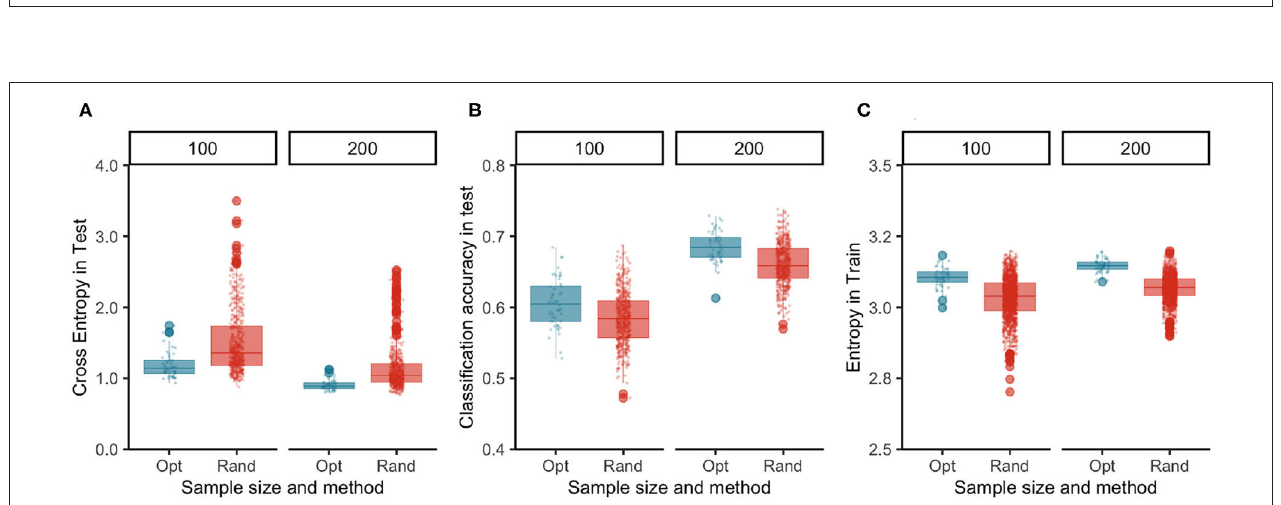
FIGURE 4 | Images selected optimally in the TRS have higher entropy in their label distributions than of the random samples (C) and the generalization performance of the model measured by both loss (A) and accuracy (B) functions in the test dataset indicate that optimally selected samples yield better models than the ones built on random